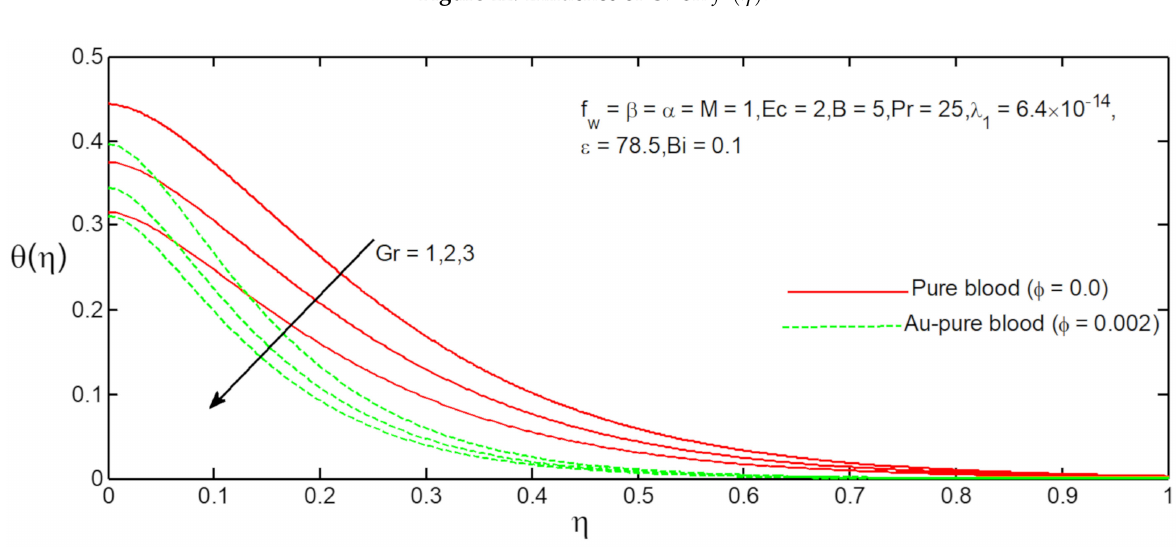
Figure 13. Influence of Gr on θ ( η )